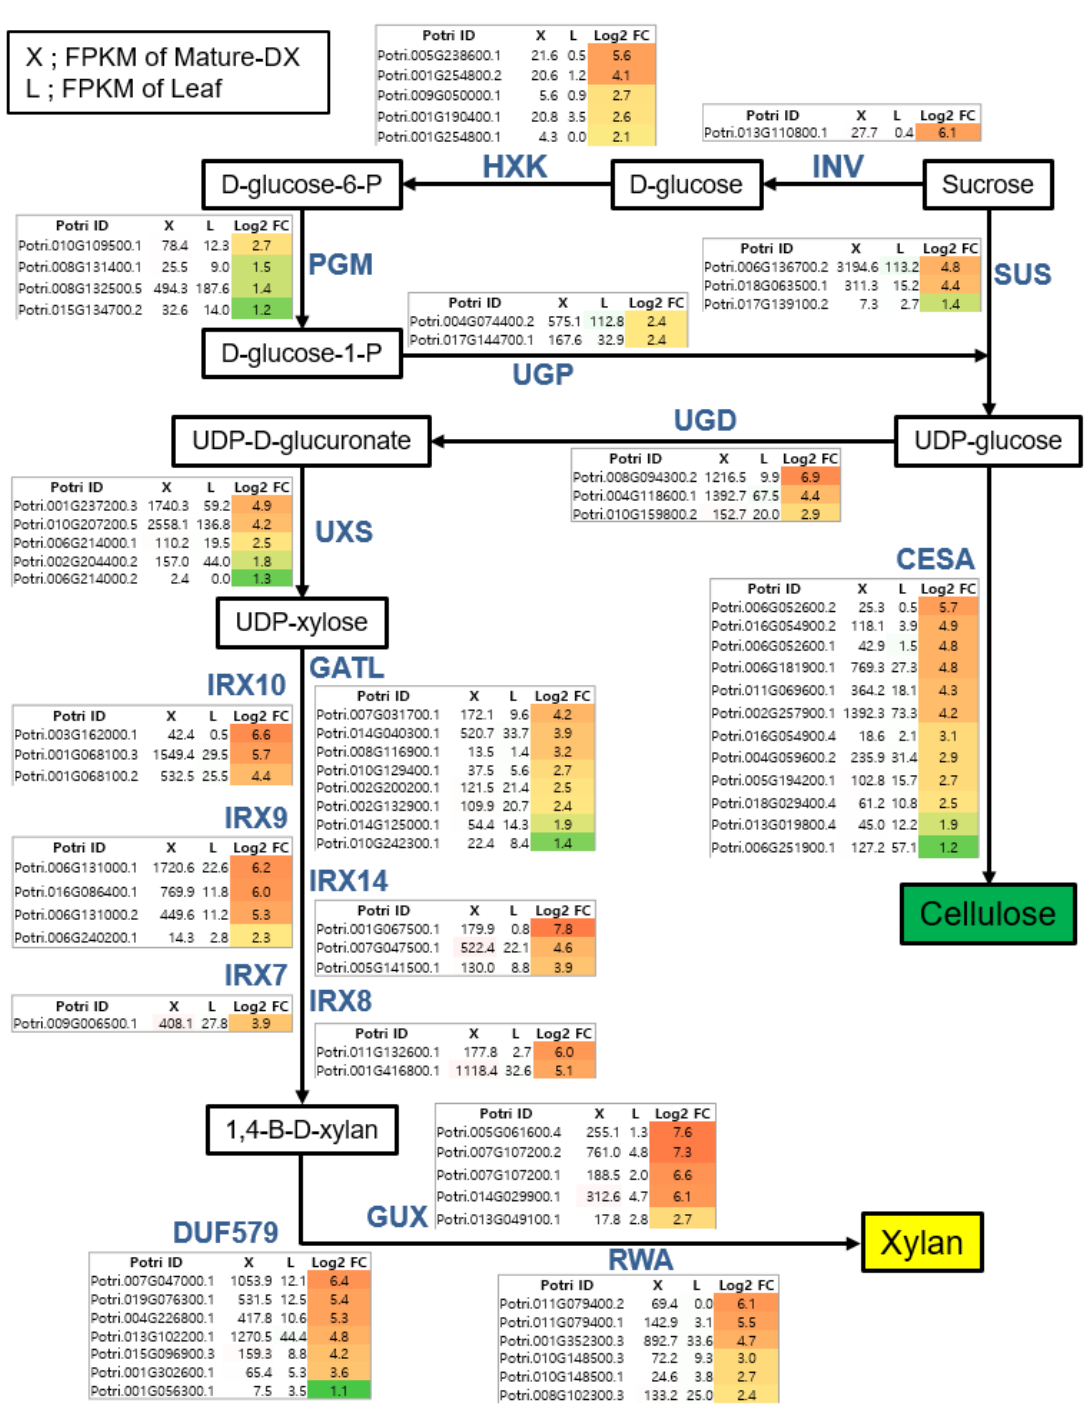
Figure 3. Identification of major players within cellulose and xylan biosynthetic pathways for secondary wall formation. Metabolites in each step of the biosynthetic pathway are shown in the box and all related genes are shown to the side. Fold change (X / L) was calculated in Log2. X is a FPKM value of mature developing xylem (MDX) and L (Leaf without major veins) represents the leaf FPKM value. Color gradient according to the fold change values was visualized.